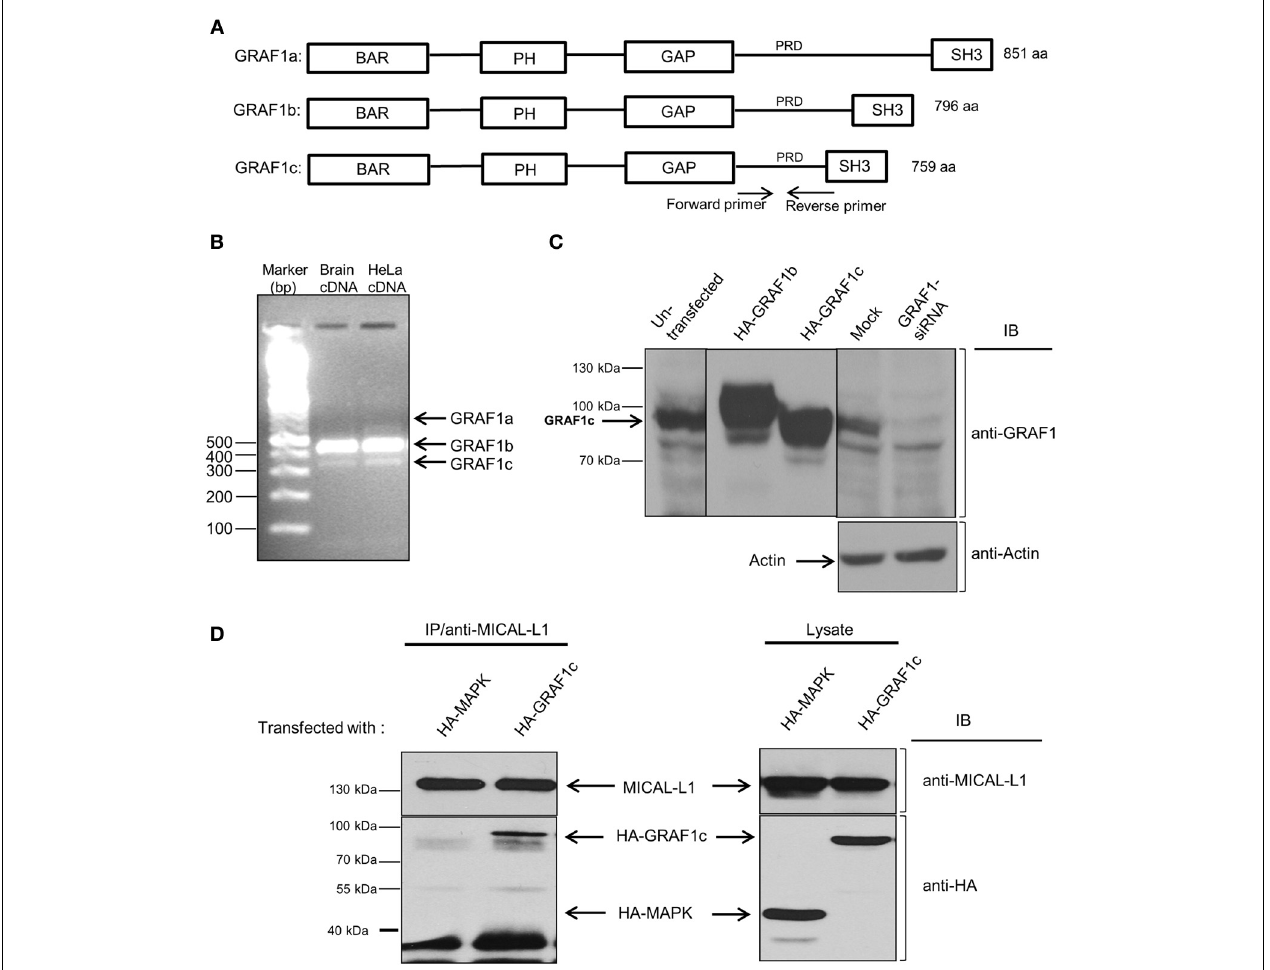
FIGURE 1 | HeLa cells predominantly express the GRAF1c isoform, which interacts with the hub-protein, MICAL-L1. (A) The domain architecture of the three GRAF1 isoforms. (B) GRAF1 isoforms (a, b, and c) were amplified from either human brain or HeLa cDNA libraries with two primers as indicated in (A) . (C) Cells were either left in culture, or transfected with either HA-GRAF1b, or HA-GRAF1c for 16h. In the left panel, the cells were subsequently mock-treated or treated with GRAF1-siRNA for 72h before being lysed on ice. Lysates were subjected to 8% SDS-PAGE, followed by immunoblotting with anti-GRAF1 and anti-Actin antibodies